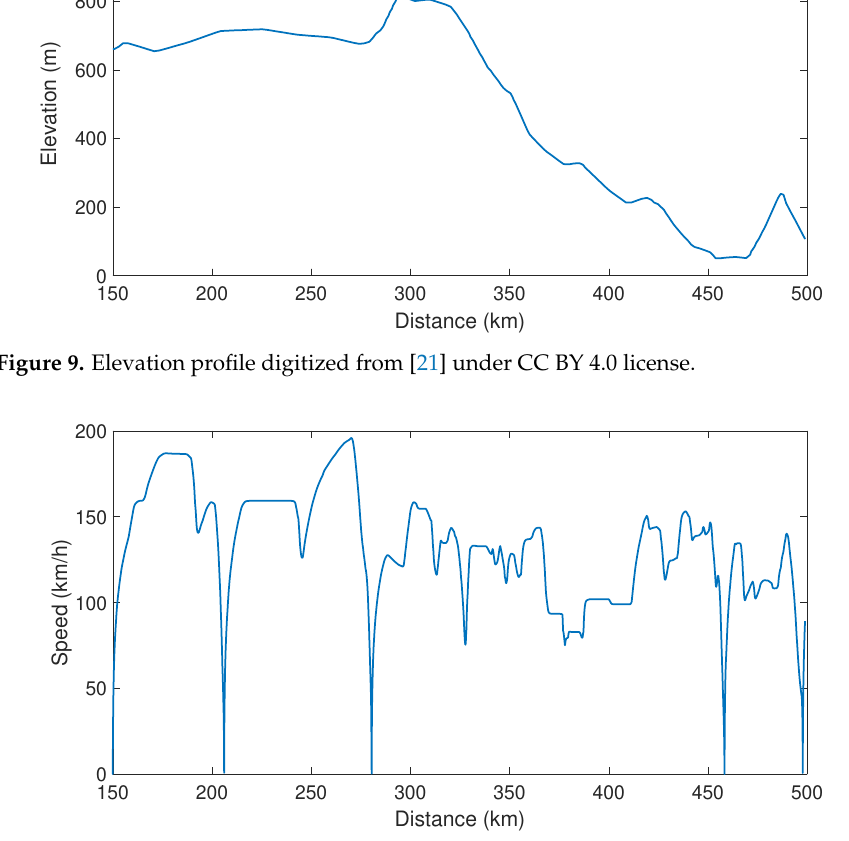
Figure 10. Speed profile digitized from [21] under CC BY 4.0